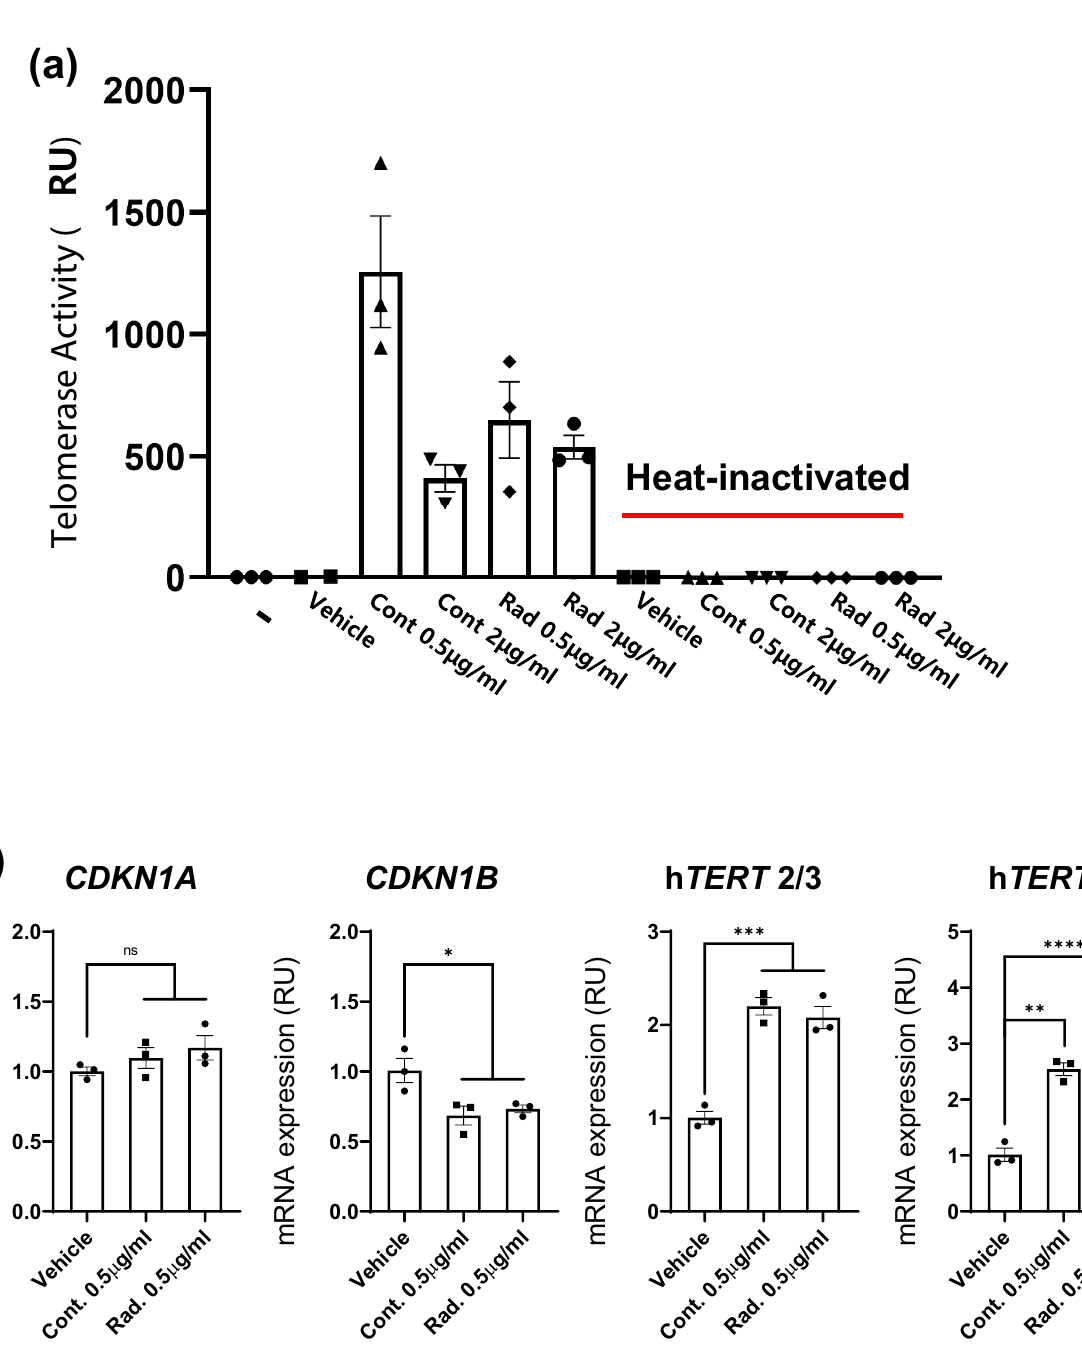
Figure 5. Anti-aging effect of a mixture of plant extracts from agrimonia, houttuynia, licorice, peony, and phellodendron (hereafter AHLPP). HaCaT cells were treated with indicated concentration of control and γ-irradiated AHLPP extracts. ( a ) Treated cells were harvested and disrupted in non-denatured buffer. Activity of telomerase was determined based on relative amplification of external telomerase substrates (TS primer). Heat- inactivated cell lysate was used as a negative control. ( b ) Analyses of aging-associated genes: Cyclin Dependent Kinase Inhibitor 1A ( CDKN1A : p21), Cyclin Dependent Kinase Inhibitor 1A ( CDKN1B : p16), Telomerase reverse transcriptase ( TERT ). The same volume of water was used as vehicle control. Asterisks indicate statistical significance. One-way ANOVA revealed statistical significance. * p < 0.05, ** p < 0.01, *** p < 0.005, **** p < 0.0001, ns